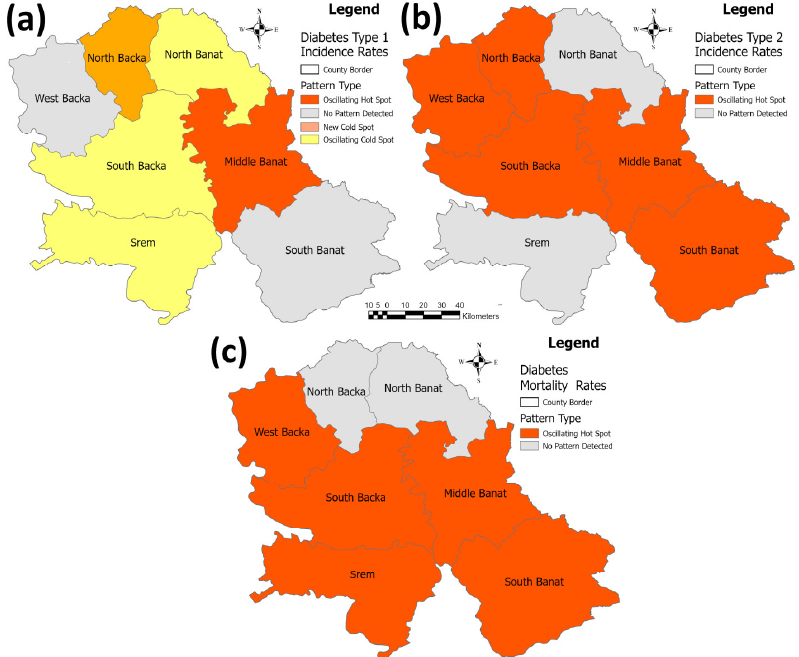
Figure 18. Identified patterns in the emerging hot spot analysis for the diabetes incidence/mortality rates per 100,000 population in the province: ( a ) incidence rates for type 1 diabetes ( b ) incidence rates for type 2 diabetes ( c ) mortality rates for both diabetes types. From 2010 to 2019, the highest values of the incidence rates of both diabetes types were recorded in the Middle Banat County, followed by the West Backa, North Banat, and South Banat Counties (Figure 19a). The lowest value of the incidence rate in the course of the analyzed period was registered in the Srem County.